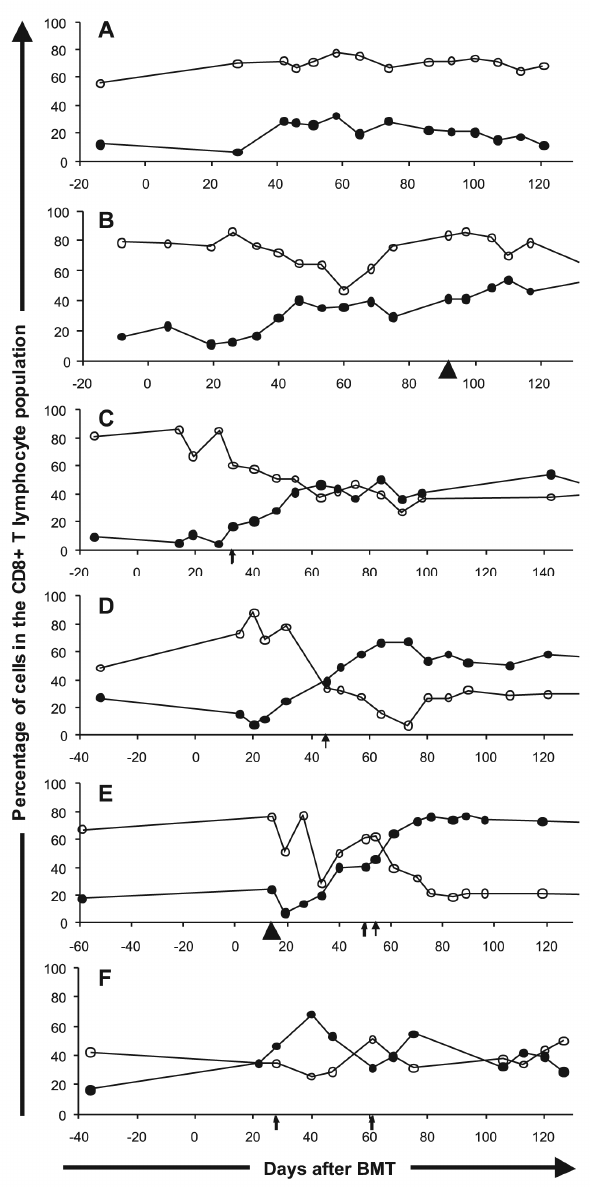
Figure 3 - CD28+ (open circles) and CD57+ (closed circles) subpopula- tion percentages among CD8+ T lymphocytes in selected BMT recipients. Arrows represent positive antigenemia and arrowheads represent GVHD. (A) Allogeneic BMT in a patient who did not develop CMV antigenemia or GVHD. (B) Allogeneic BMT in a patient who developed GVHD. (C) and (D) Allogeneic BMT in two patients with CMV antigenemia. (E) Allogeneic BMT in a patient who developed both GVHD and CMV antigenemia at dis- tinct moments during follow-up. (F) Autologous BMT in a patient developing CMV antigenemia on two occasions during